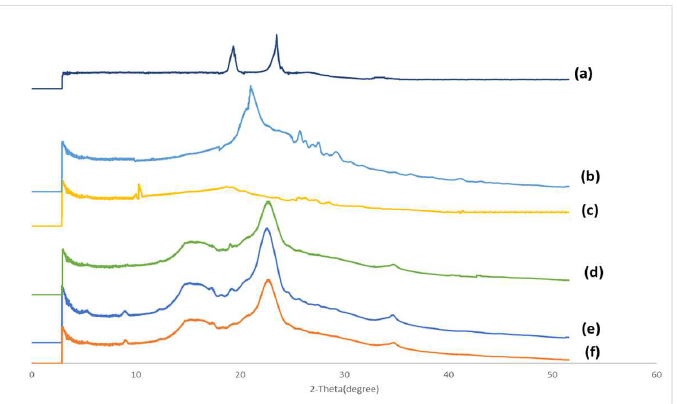
Figure 8. XRD spectra of ( a ) poloxamer 407, ( b ) Aerosil®, ( c ) magnesium stearate, ( d ) MCC, ( e ) For- mulation B, and ( f ) the physical mixture of Formulation B.